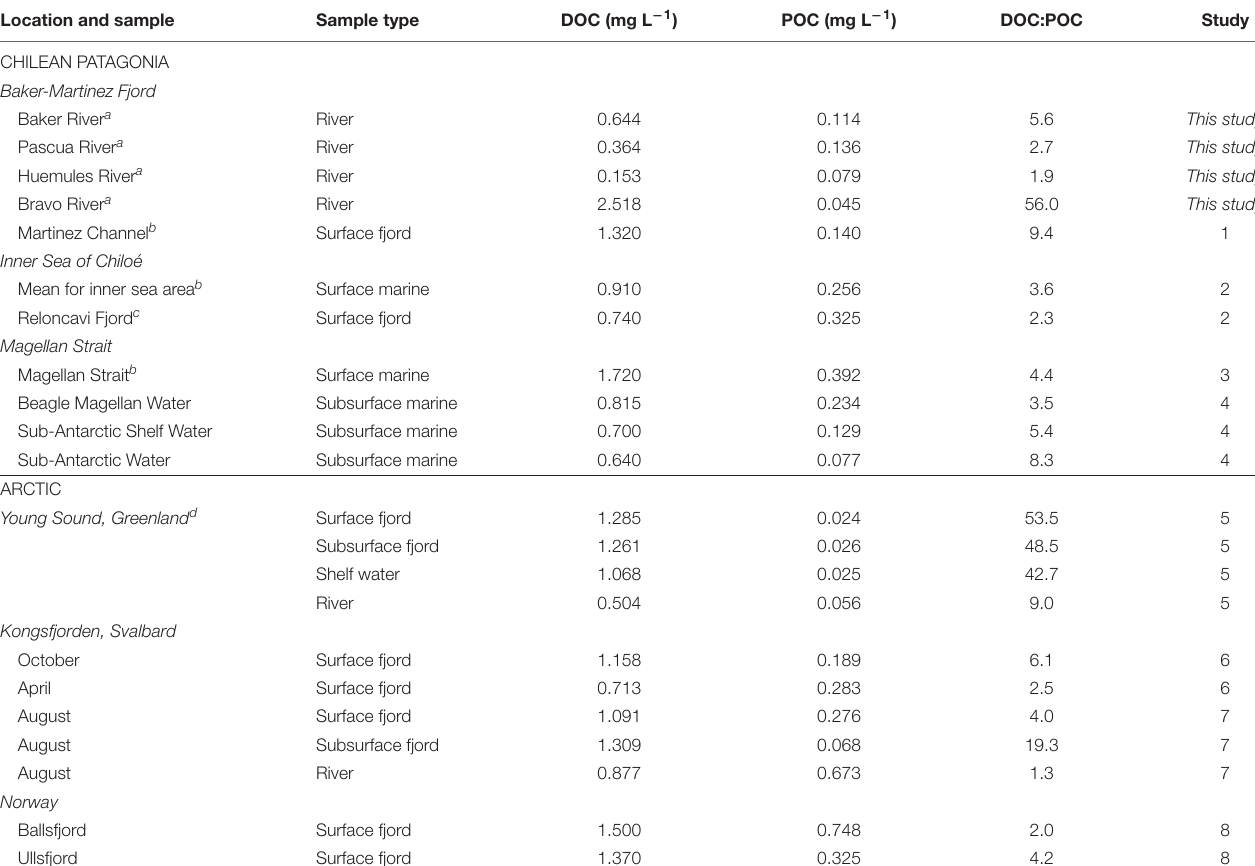
a Annual mean concentrations reported in Table 4 . b DOC:POC calculated from concentrations converted from depth-integrated concentrations reported in study. c As b. but concentrations read off from graph in study and expressed as mean for all stations within Reloncavi Fjord. d Mean concentrations for summer (July) study period; molar DOC concentrations converted into mg L − 1